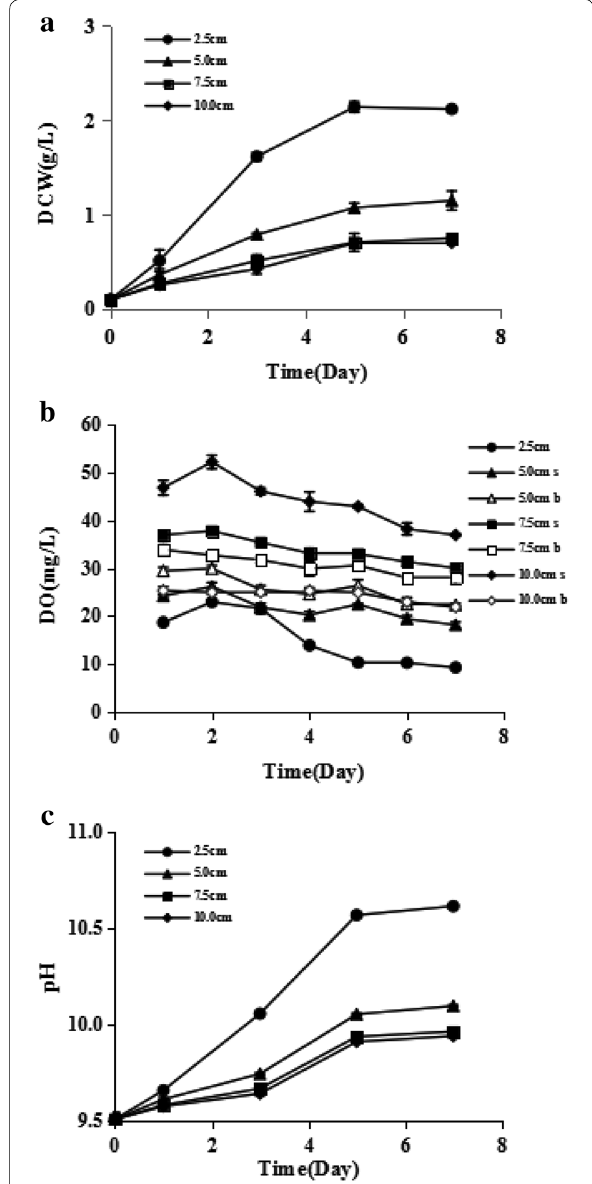
Fig. 4 Culture of Euhalothece sp. ZM001 in horizontal PBR with rock- ing cycle of 2 s and light intensity of 135 μmol/m 2 /s lux: a biomass production; b dissolved oxygen (s: surface; b: bottom); c pH